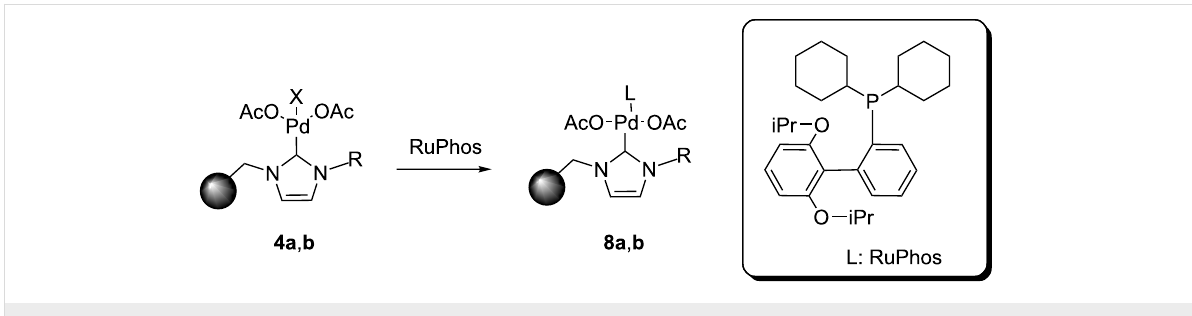
thoroughly washed to remove any remaining non-coordinated RuPhos (0.37 and 0.57 mequiv of Pd/g for 8a and 8b , respec-